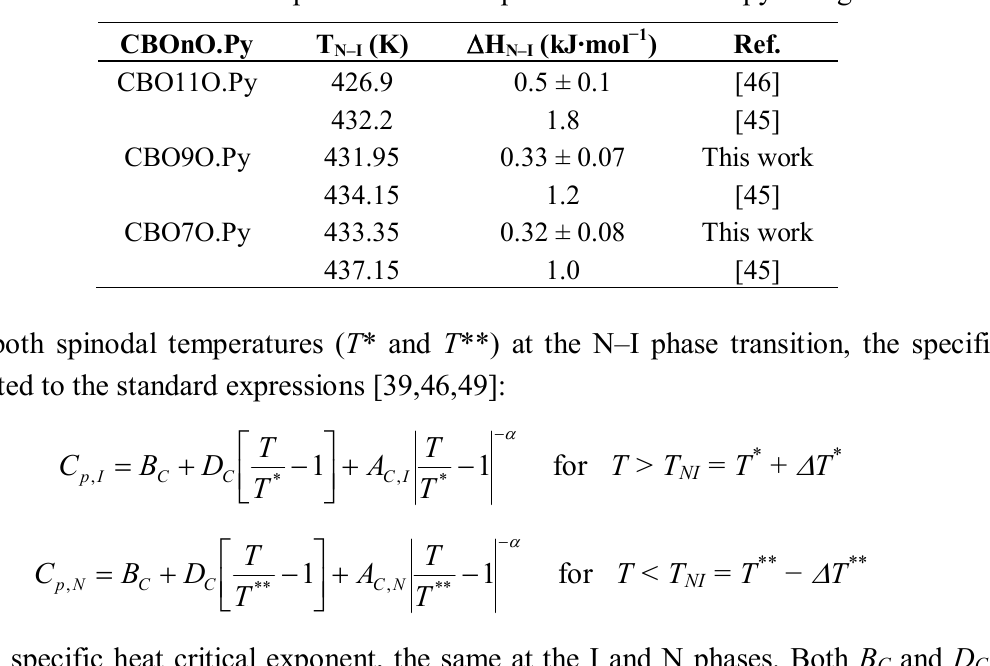
Table 1. Nematic-isotropic transition temperatures and enthalpy changes.